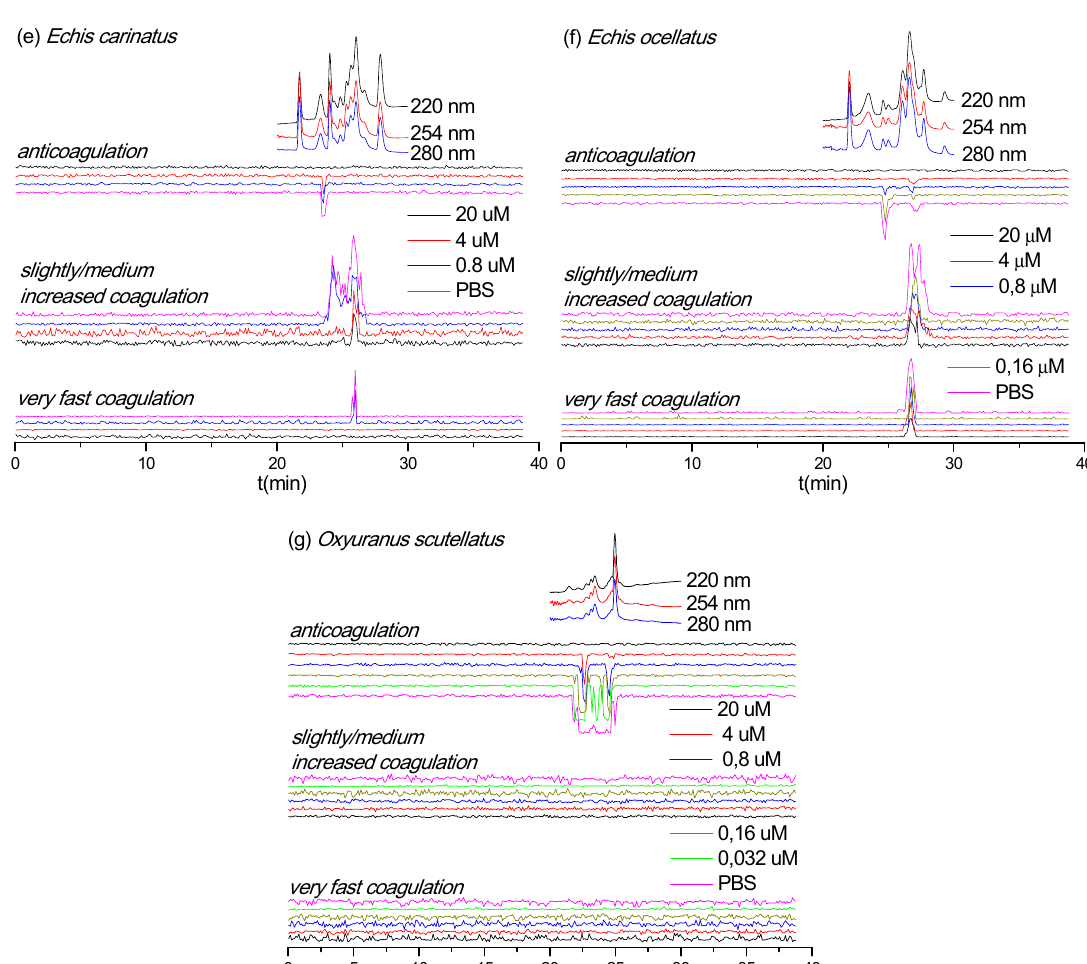
Figure 4. Part 2 —(continuation of figure from previous page). Coagulopathic toxicity chromatograms Figure 4. Coagulopathic toxicity chromatograms in the presence of various varespladib in the presence of various varespladib concentrations for nanofractionated venom toxins from ( a concentrations for nanofractionated venom toxins from ( a ) B. asper , ( b ) C. rhodostoma , ( c ) D. acutus , ( d )